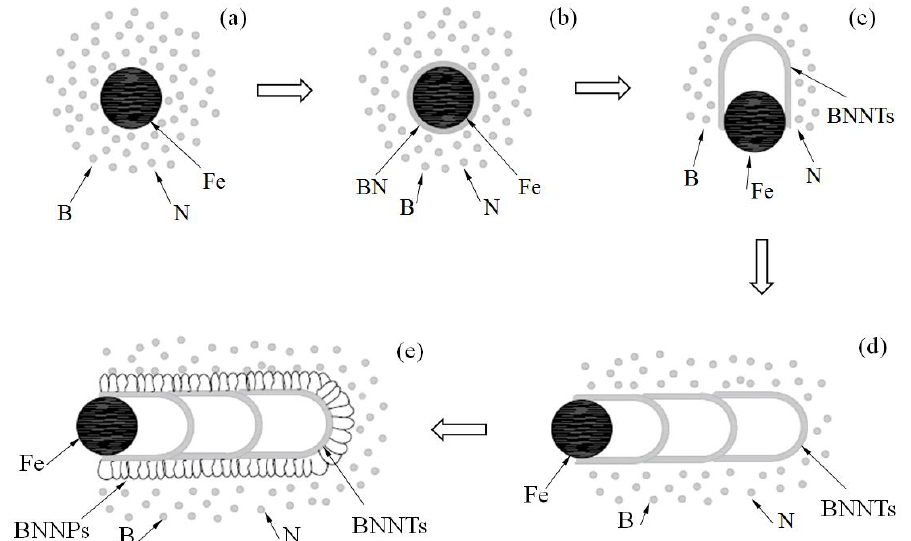
Figure 7. Growth process of the coral-like boron nitride micro-/nanostructure. ( a ) Melting of iron particles and adsorption of B, N atoms ( b ) Formation of BN crystal layer ( c ) Formation of single BN bamboo knot ( d ) Formation of bamboo-like BN nanotubes ( e ) Secondary growth of BN nanoflakes on the surface of BN nanotubes.